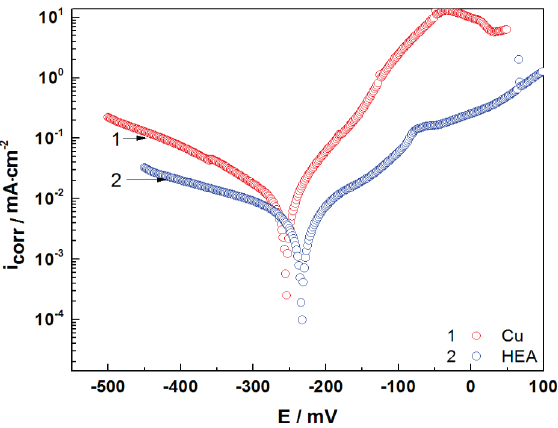
Figure 5. Polarization curves of uncoated Cu and HEA-coated copper in artificial seawater at 25 ◦ C. Table 3. The corrosion parameters of the Cu and Cu/HEA in artificial seawater at 25 ◦ C. Sample